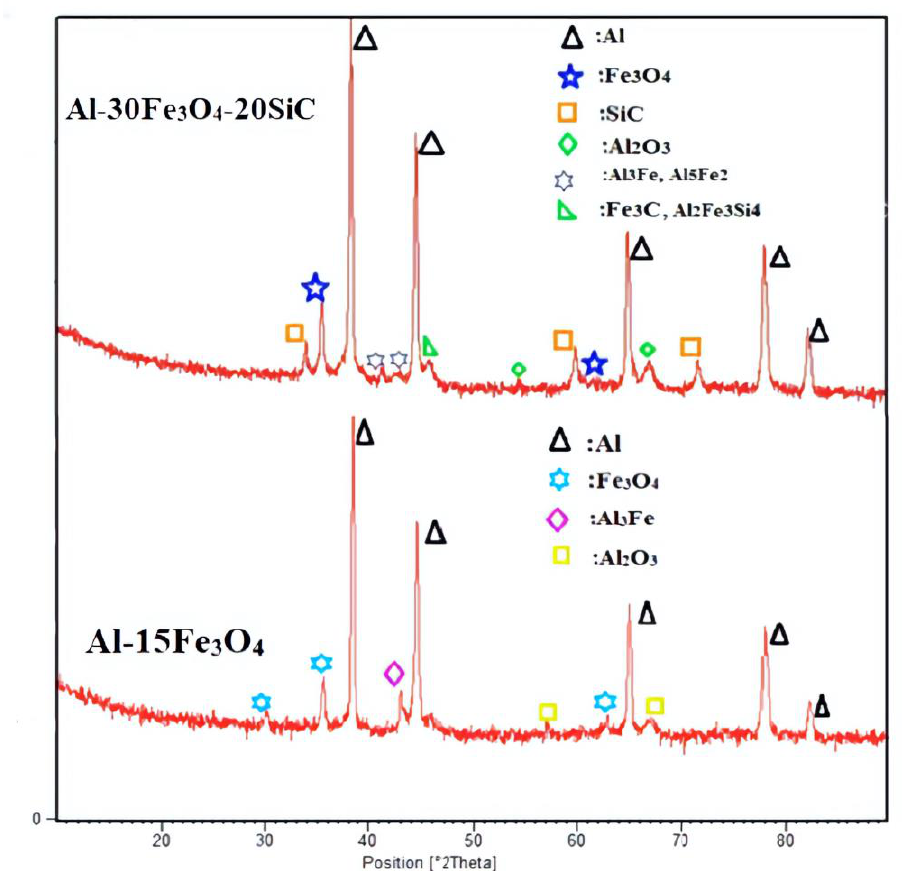
Figure 6. Shows the X-ray diffraction (XRD) analyses for the two